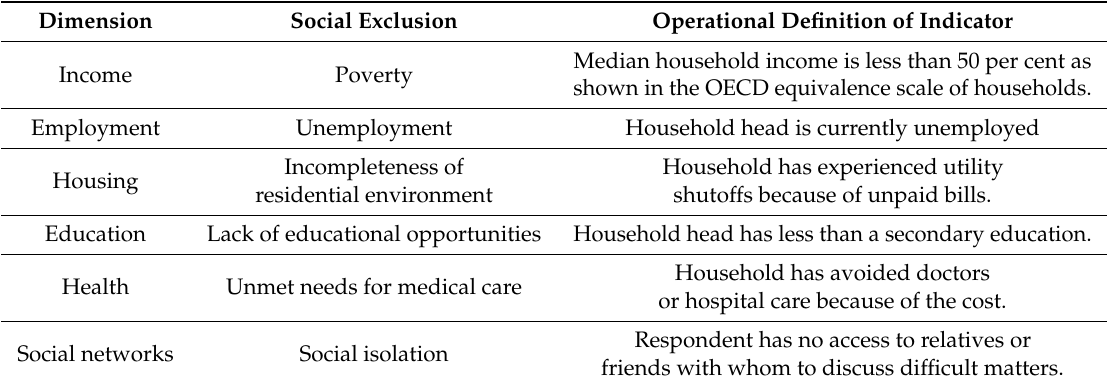
Table 1. Dimensions of social exclusion and